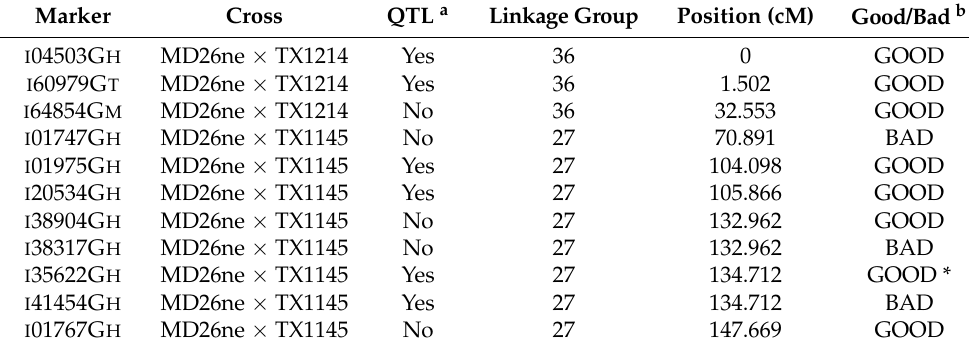
Table 3. KASP assay screening results for QTL-associated and flanking markers.